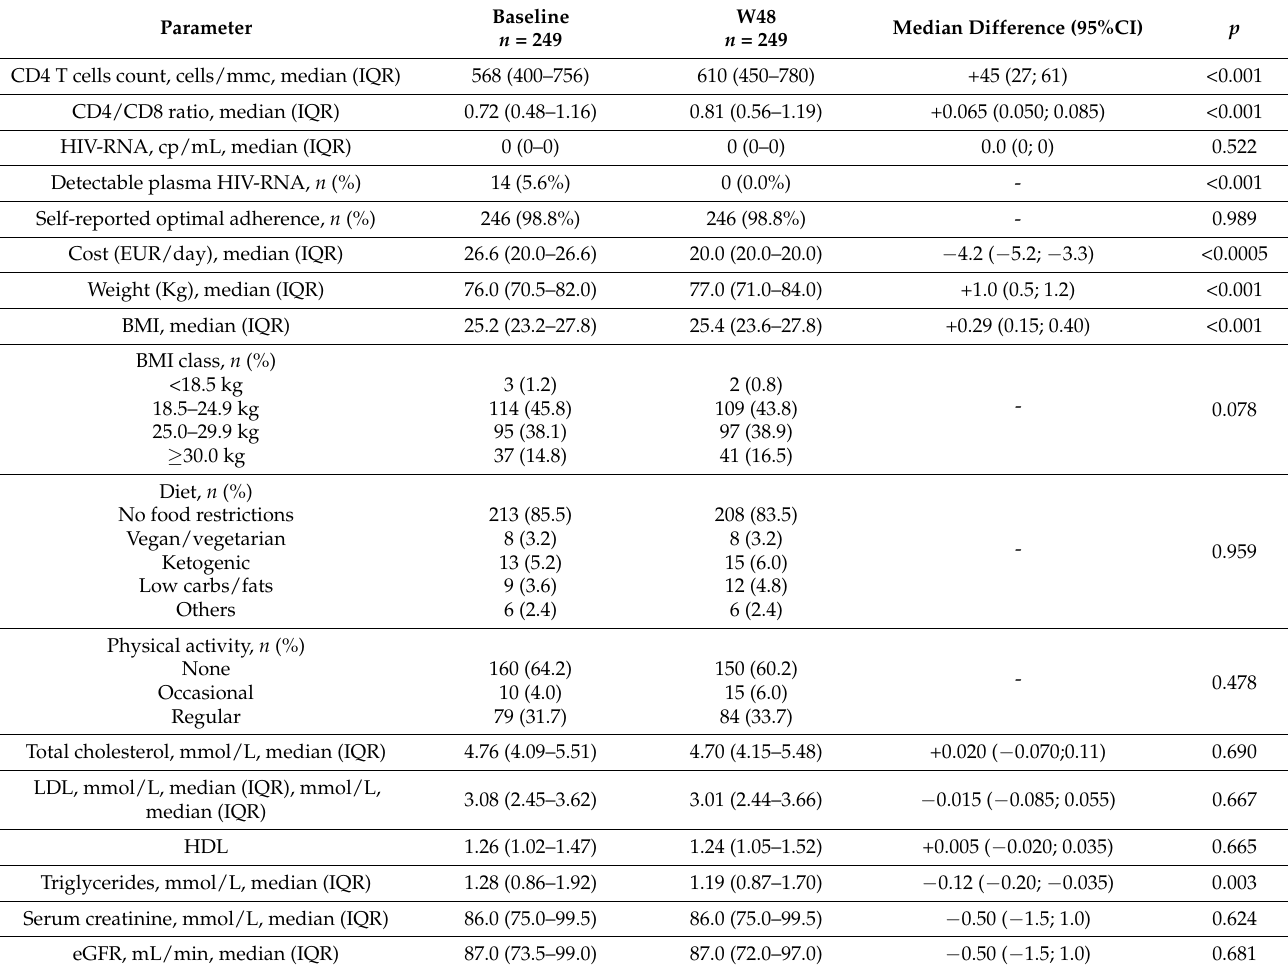
Table 2. Median difference in viro-immunological and metabolic parameters between baseline and W48 of the study